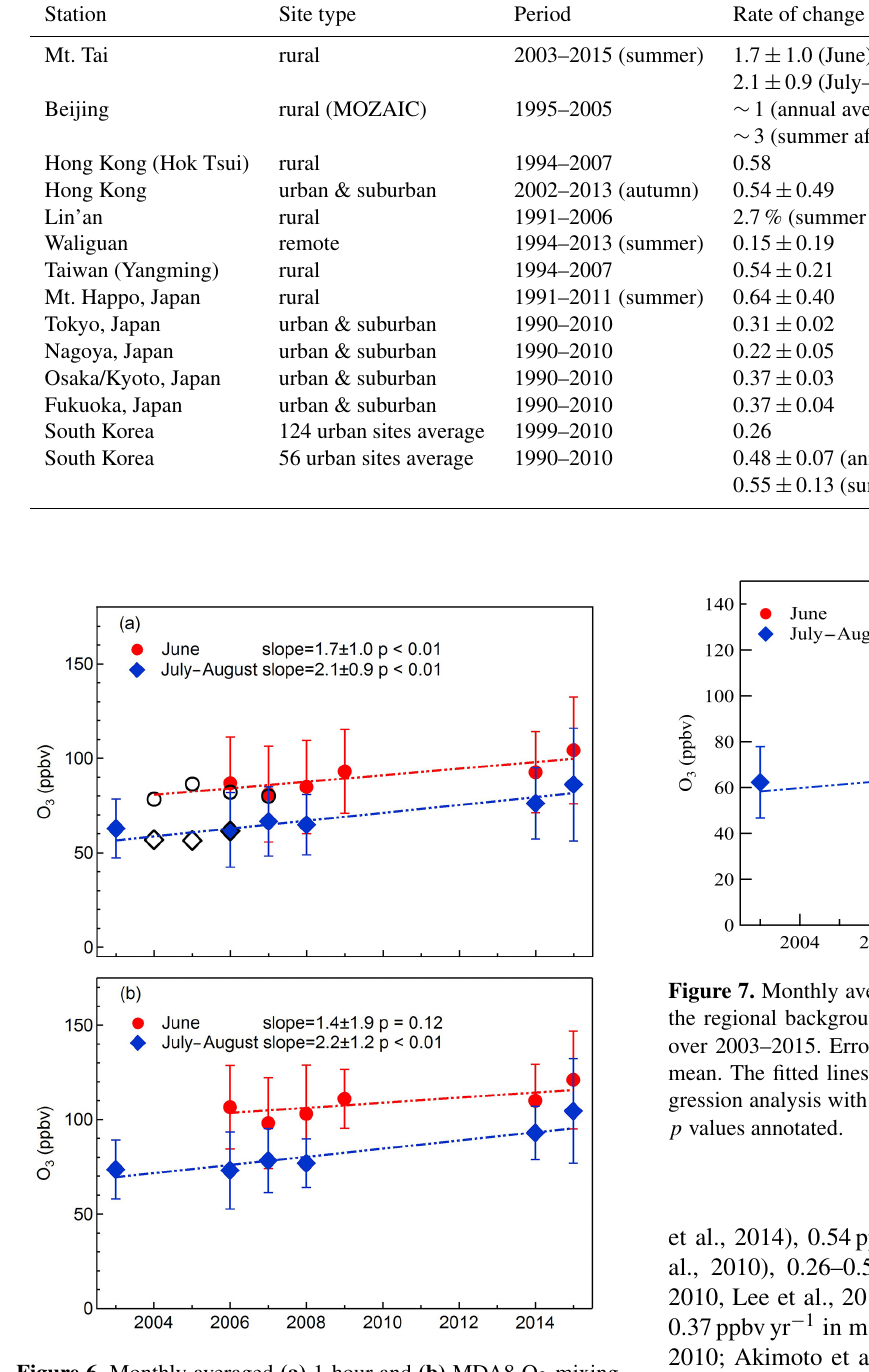
Figure 6. Monthly averaged (a) 1-hour and (b) MDA8 O 3 mixing ratios at Mt. Tai in June and July–August over 2003–2015. Error bars indicate the standard deviation of the mean. The black open cir- cles and squares represent the data taken from Kanaya et al. (2013). The fitted lines are derived from the least square linear regression analysis with the slopes ( ± 95% confidence intervals) and p values annotated.